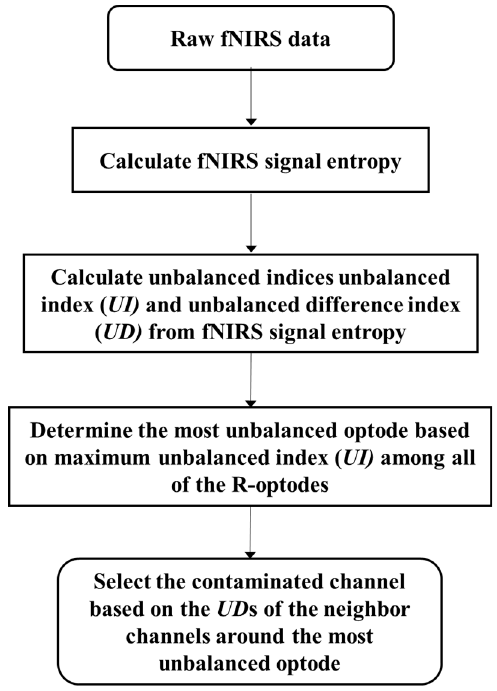
Figure 3. Contaminated channel identification flowchart.